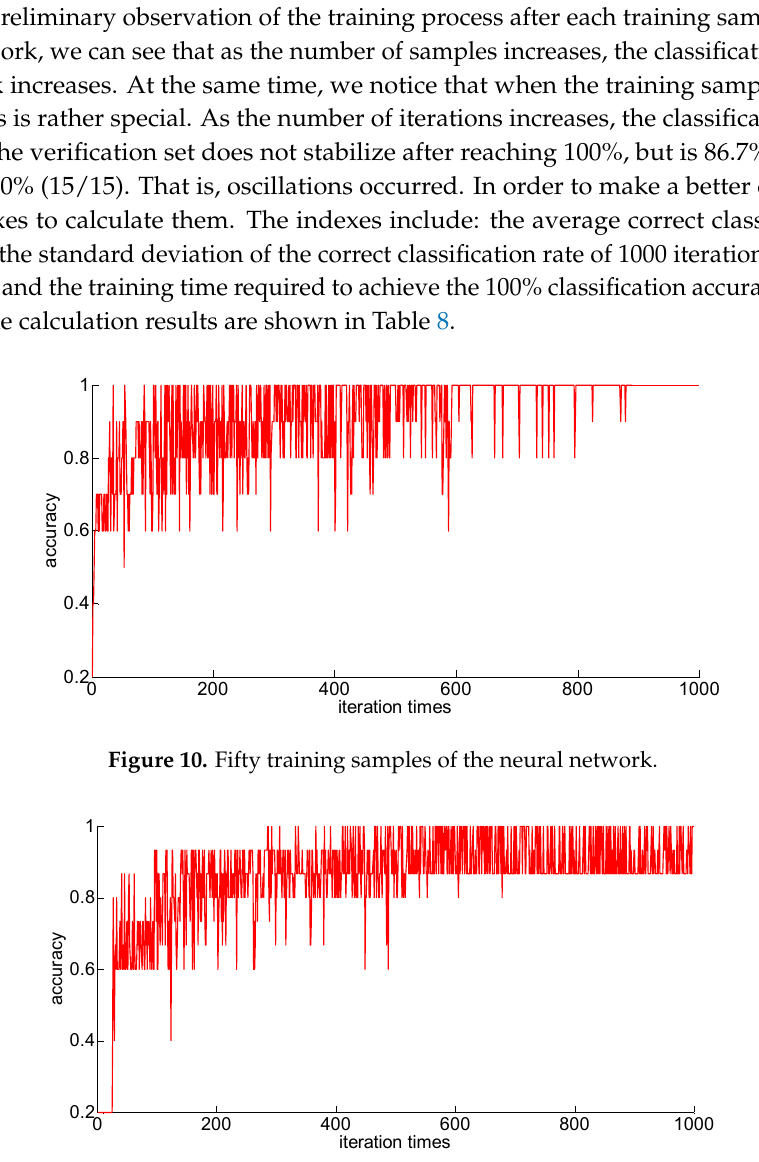
Figure 11. Seventy-five training samples of the neural network.